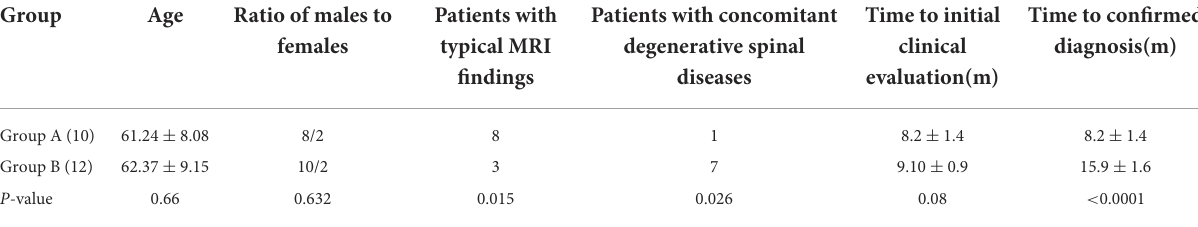
TABLE 1 Comparison of patient data between the two groups.